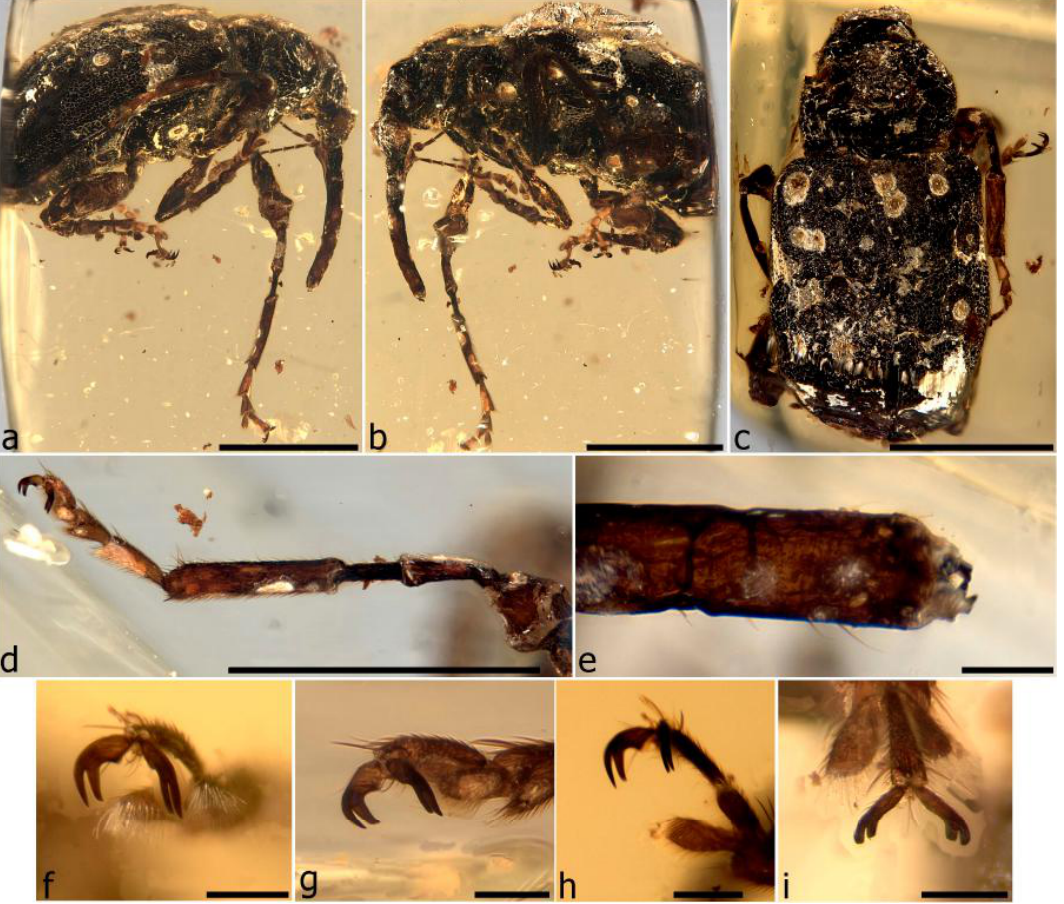
Figure 72. Myanmarus diversiunguis sp. n., holotype. Habitus, right lateral ( a ); left lateral ( b ); dorsal ( c ); protibia and tarsus ( d ); mandibles ( e ); protarsal claws ( f–i ). Scale bars: 1.0 mm (a–d); 0.1 mm (e–i).